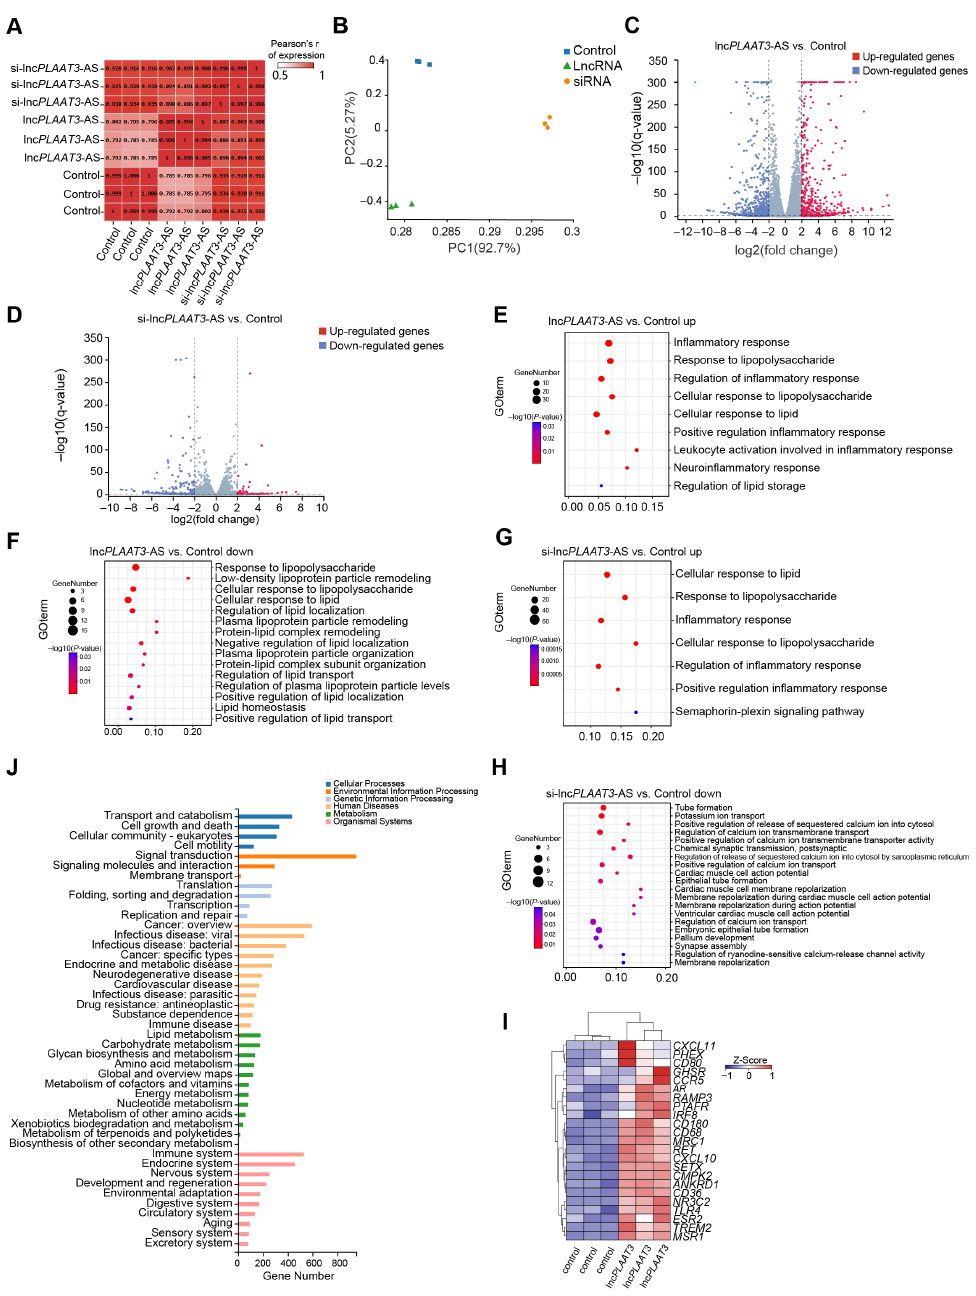
Figure 2. ( A ) Sample correlation heatmap; ( B ) principal component analysis; ( C , D ) volcano plot of differentially expressed genes. Positive values indicate upregulation, while negative values indicate downregulation. The x-axis represents the log2 scale of fold change. A significant difference in expression is indicated by the y-axis, which is the − log10 scale of the adjusted p values. The red dots in the figure indicate genes with significantly upregulated expression (at least two-fold change), blue dots indicate genes with significantly downregulated expression (at least two-fold change), and gray dots indicate genes with no significant difference in expression level. ( E – H ) The top 20 GO pathways for the differentially expressed genes according to the following comparisons: upregulated in lnc PLAAT3 -AS vs. control, downregulated in lnc PLAAT3 -AS vs. control, upregulated in si-lnc PLAAT3 -AS vs. control, downregulated in si-lnc PLAAT3 -AS vs. control; ( I ) differentially expressed gene pathway enrichment analysis; ( J ) All enriched GO and KEGG